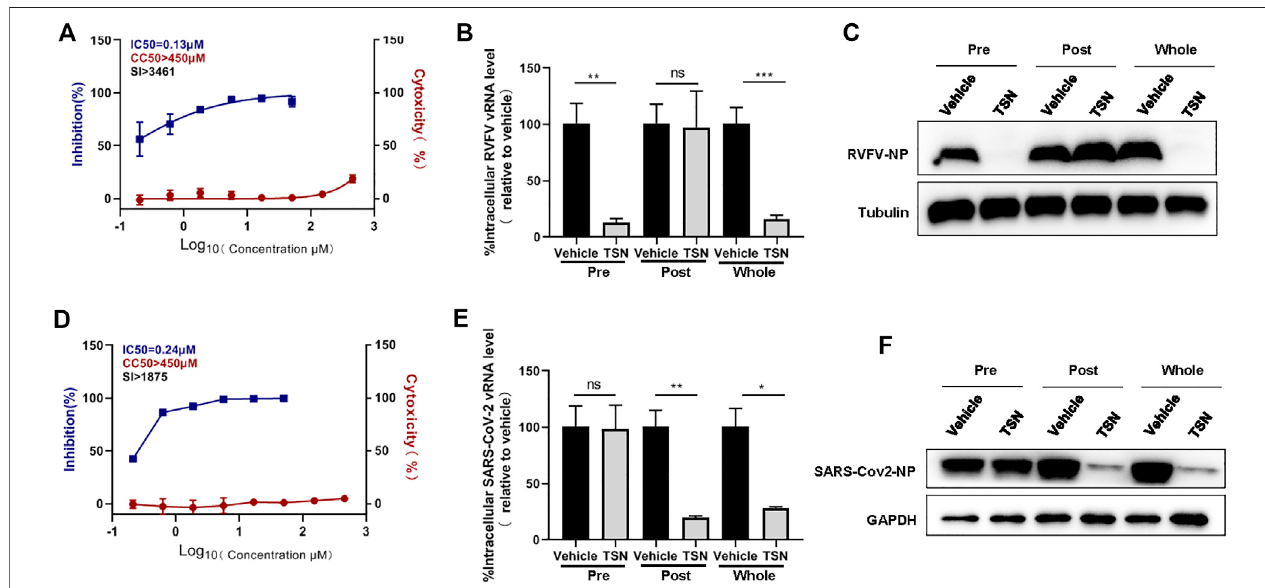
FIGURE 6| Inhibitory effects of toosendanin on Rift Valley fever virus (RVFV) and SARS-CoV-2 infection. (A) The dose-dependent inhibitory activity oftoosendanin againstRVFVinfectiononHUVECcells.HUVECcellspre-treatedwithindicatedconcentrationsoftoosendaninwereinfectedwithRVFV(MOI (cid:1) 2),cellsupernatantswere harvestedfor viral RNA quanti fi cation byqRT-PCR. Cell viability on HUVEC cells wasdetermined byCCK-8.The left and right Y -axis represent inhibition and cytotoxicity rate of the toosendanin. (B,C) Time-of-addition assay of toosendanin on RVFV infection. HUVEC cells infected with RVFV (MOI (cid:1) 2) for 2 h were treated with toosendanin(1 μ M)for1 hpre-infection(pre),post-infection(post),andwholetime(whole).Infectedcellswerecollectedat12 hpostinfectionforviralRNAquanti fi cation (B) and western blot (C) . (D) The dose-dependent inhibitory activity of toosendanin against SARS-CoV-2 infection on Vero-E6 cells. Vero-E6 cells pre-treated with indicated concentrations of toosendanin were infected with SARS-CoV-2 (MOI (cid:1) 0.01), cell supernatants were harvested for viral RNA quanti fi cation by qRT-PCR. Cell viability on Vero-E6 cells was determined by CCK-8. The left and right Y -axis represent inhibition and cytotoxicity rate of toosendanin. (E,F) Time-of-addition assay of toosendanin on SARS-CoV-2 infection. Vero-E6 cells infected with SARS-CoV-2 (MOI (cid:1) 0.01) for 1 h were treated with toosendanin (1 μ M) for 1 h pre-infection (pre), post-infection (post), and whole time (whole). Infected cells were collected at 24 h post infection for viral RNA quanti fi cation (E) and western blot (F) . TSN, toosendanin. Datashownaremeans ± SD( n (cid:1) 3).Comparisonofmeanvalues (B,E) betweentwogroupswereanalyzed byStudent ’ sttest.* p < 0.05;** p < 0.01;*** p < 0.001;ns,no signi fi